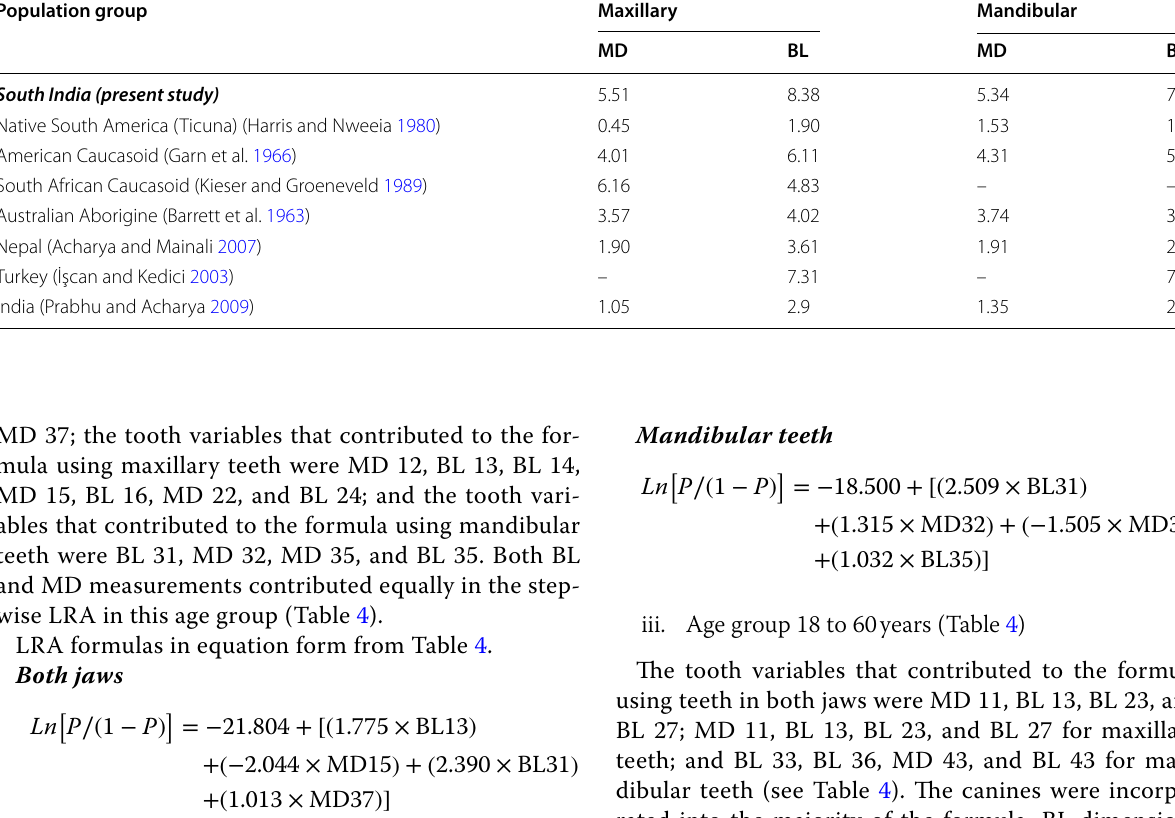
Table 5 Mean percentage dimorphism for different populations Population